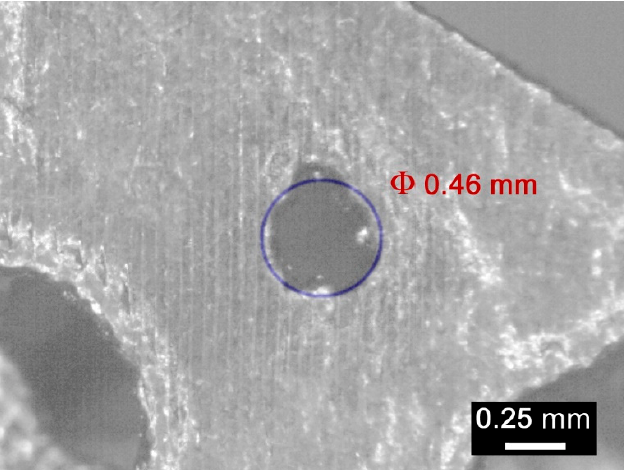
Figure 16. Detail of roundness error for the circle of 0.46 mm nominal diameter.